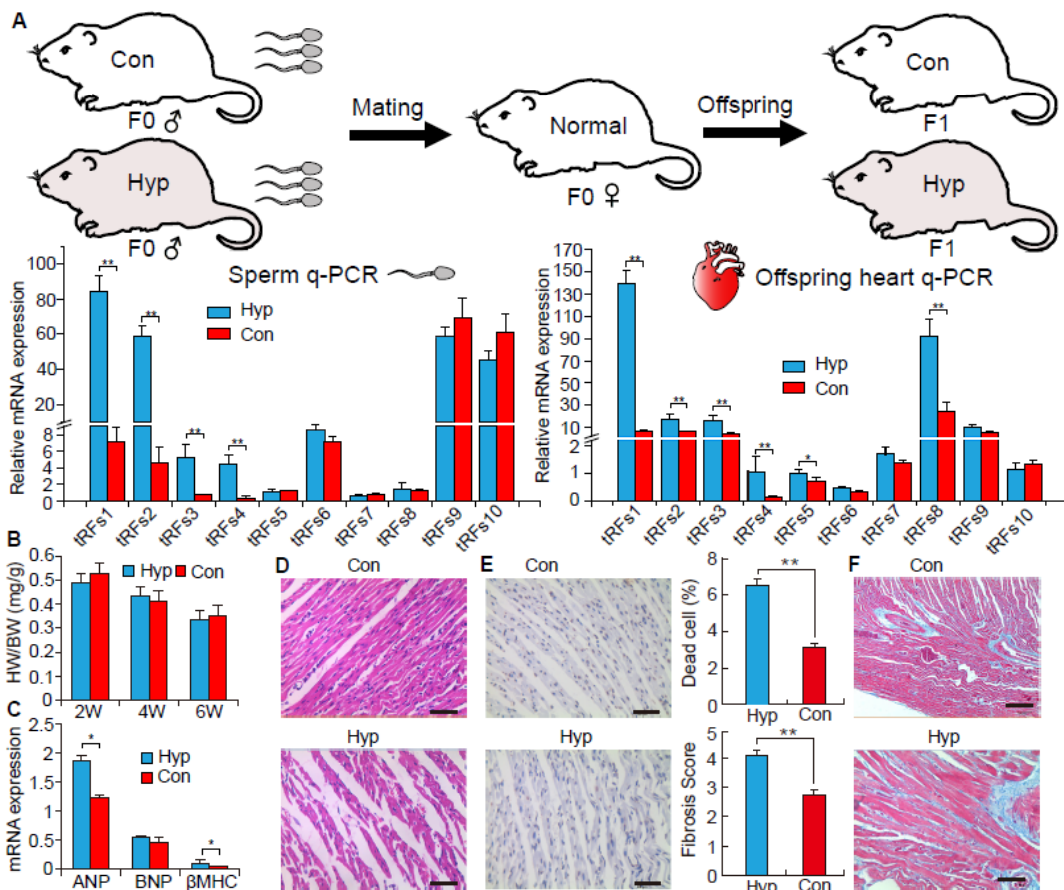
Figure 3. The function of tRFs on the intergenerational inheritance of cardiac hypertrophy. ( A ): The expression levels of tRFs in F0 sperm and F1 offspring heart, n = 8; ( B ): The ratio of the heart weight to body weight (HW/BW) in F1 offspring Con and Hyp groups, n = 8; ( C ): Relative mRNA expression levels of ANP , BNP , and β-MHC in F1 offspring heart, n = 8; ( D ): Histological analysis of the F1 offspring heart tissue by HE staining. Scale bar = 50 μm, n = 8; ( E , F ): Cell apoptosis and cardiac fibrosis analysis of F1 offspring heart using TUNEL staining and Masson staining, respectively. Scale bar = 50 μm, n = 8. Data are means ± SD. * p < 0.05, ** p < 0.01.